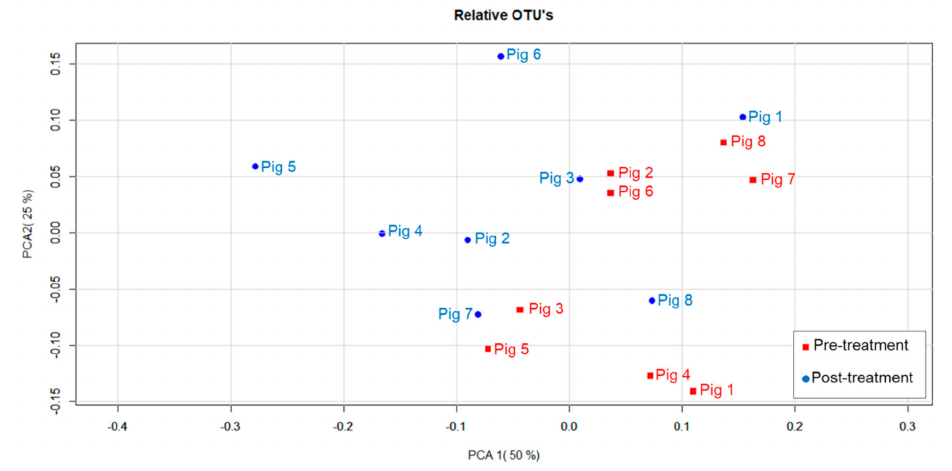
Figure 3. Principal coordinate analysis of fecal microbiomes. Relative total number of operational taxonomic units (OTUs) in the fecal microbiome of each animal ( n = 8) pre-treatment ( (cid:4) ) and